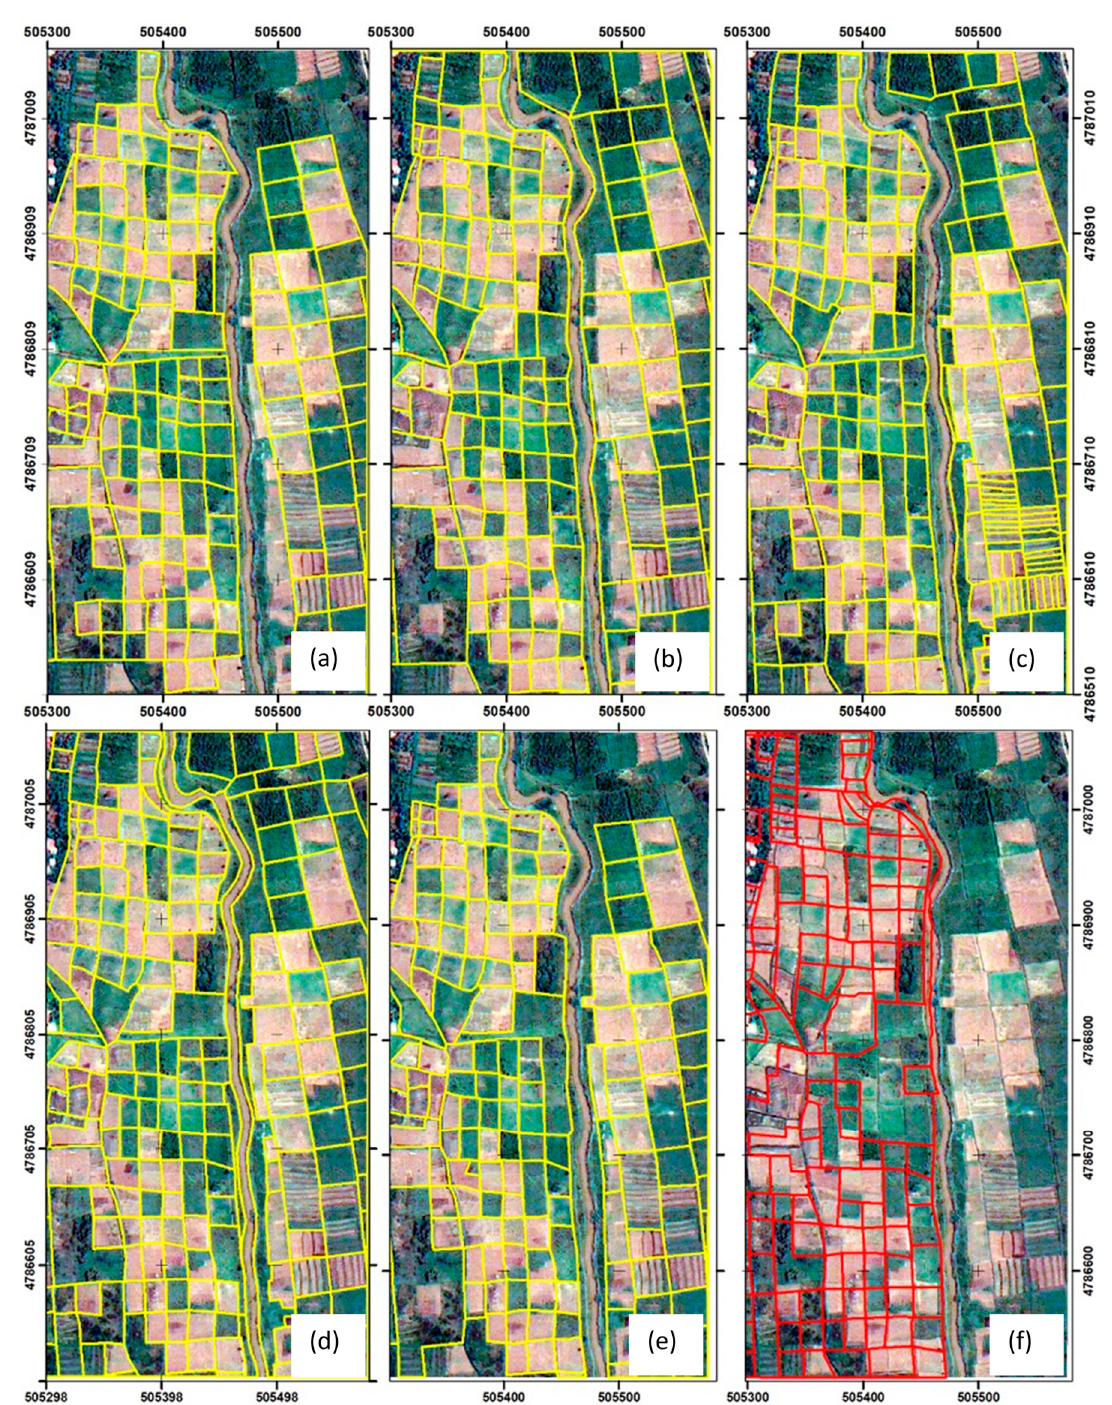
Figure 6. Manually digitised parcel boundaries. ( a – e ): manually extracted boundaries. ( f ): existing legal boundaries